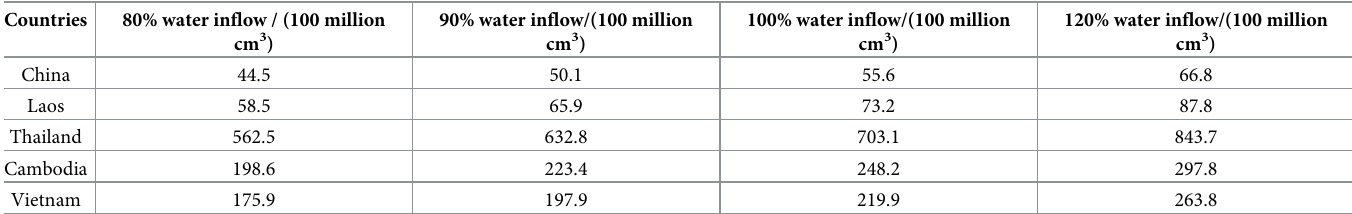
Table 3. Allocation of water resources in five countries of the Lancang-Mekong River Basin.